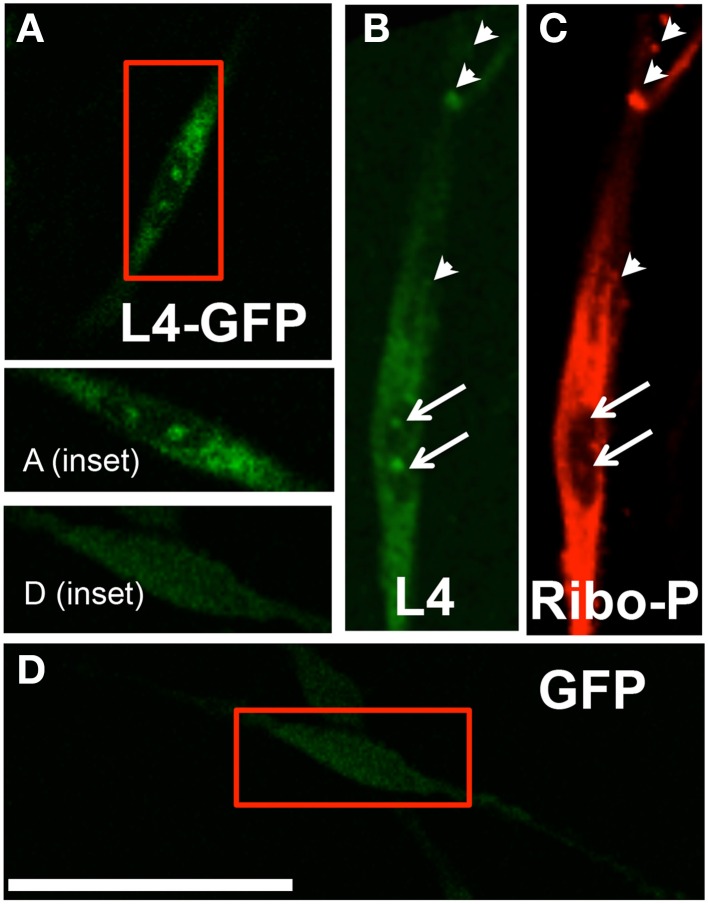
(A) Typical pattern of a transfected Schwann cell expressing L4-GFP (magnified in inset); (B) A separate schwann cell immunostained with anti-L4; (C) Schwann cell immunostained with anti-Ribo-P shows co-localization with L4 expression, based on Manders co-localization analysis (arrows indicate nucleolar labeling; arrowheads indicate prominent co-localizing puncta); (D) Transfected Schwann cell expressing GFP (magnified in inset) shows continuous low-level expression throughout cell, including the nuclear compartment, and differs from the L4-GFP labeling pattern; Scale bar: 50 μm.